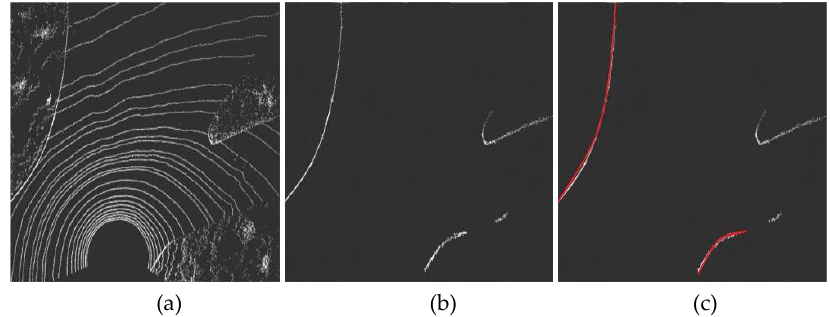
Figure 15. Curb detection of a typical Y-shaped intersection scene. ( a ) is the extracted foreground point clouds of Y-shaped intersection. ( b ) is the boundary result extracted by the algorithm. ( c ) is the boundary fitting result.